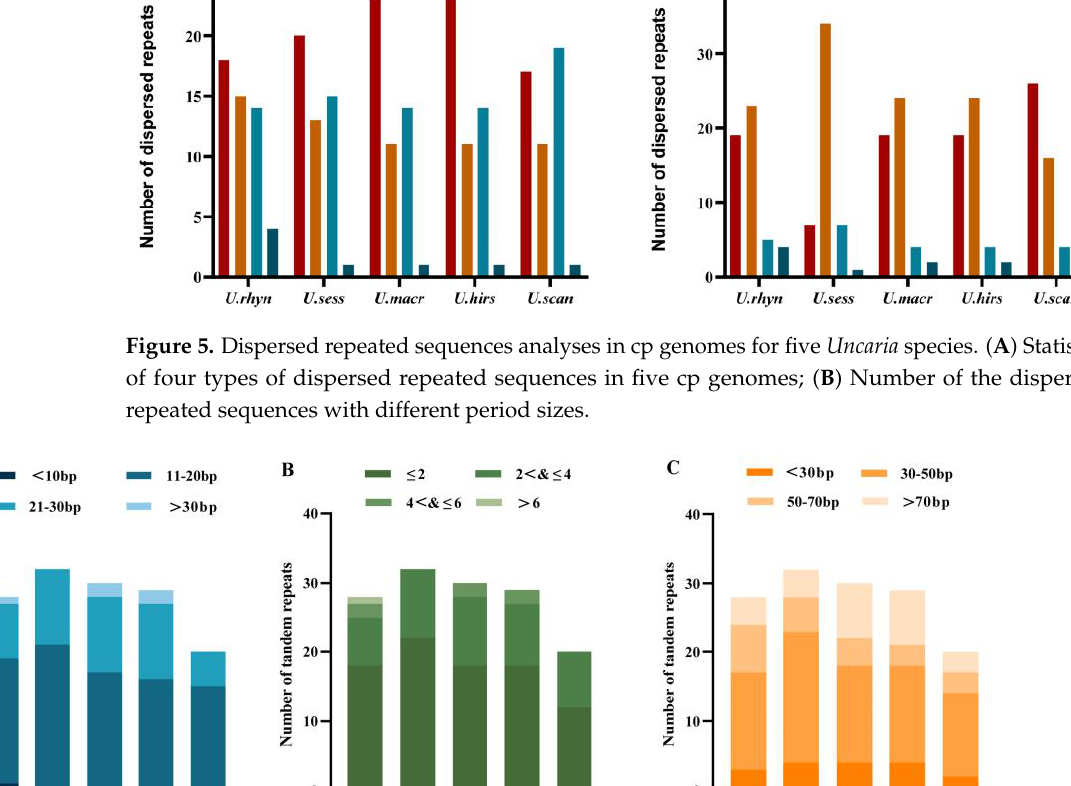
Figure 6. Tandem repeated sequence analyses for five Uncaria species in cp genomes. The number of tandem repeats with various period sizes, copy counts, and sequence lengths are shown in ( A , B , C ), respectively.